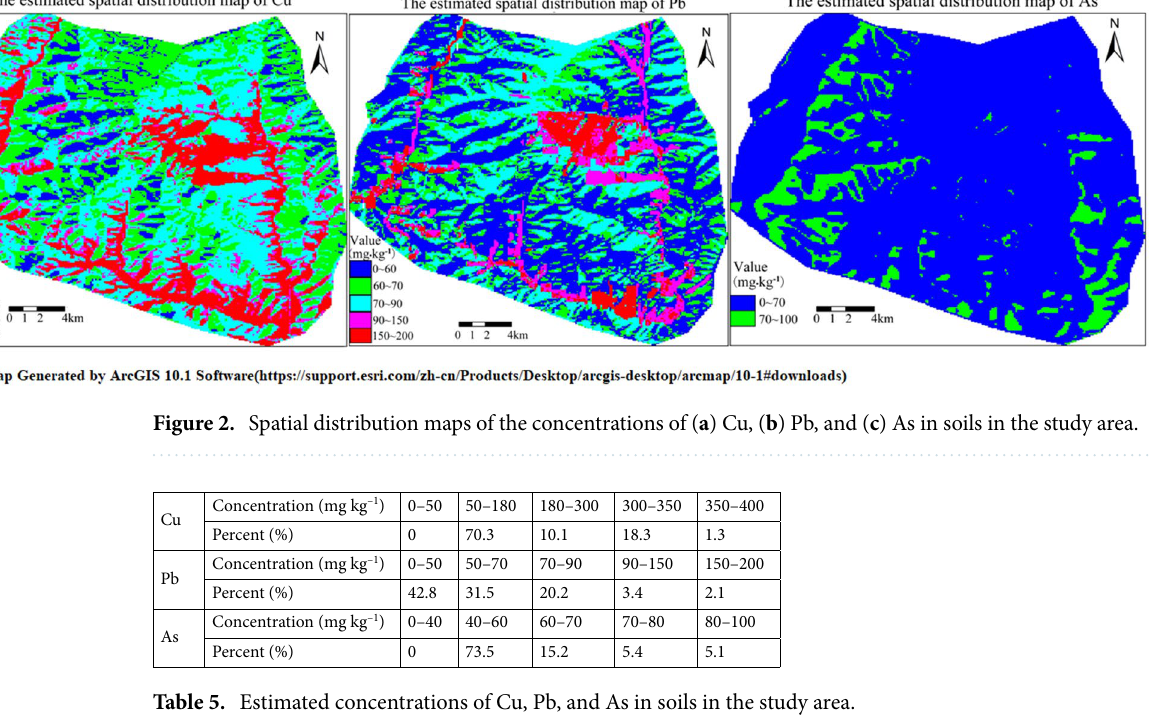
Table 5. Estimated concentrations of Cu, Pb, and As in soils in the study